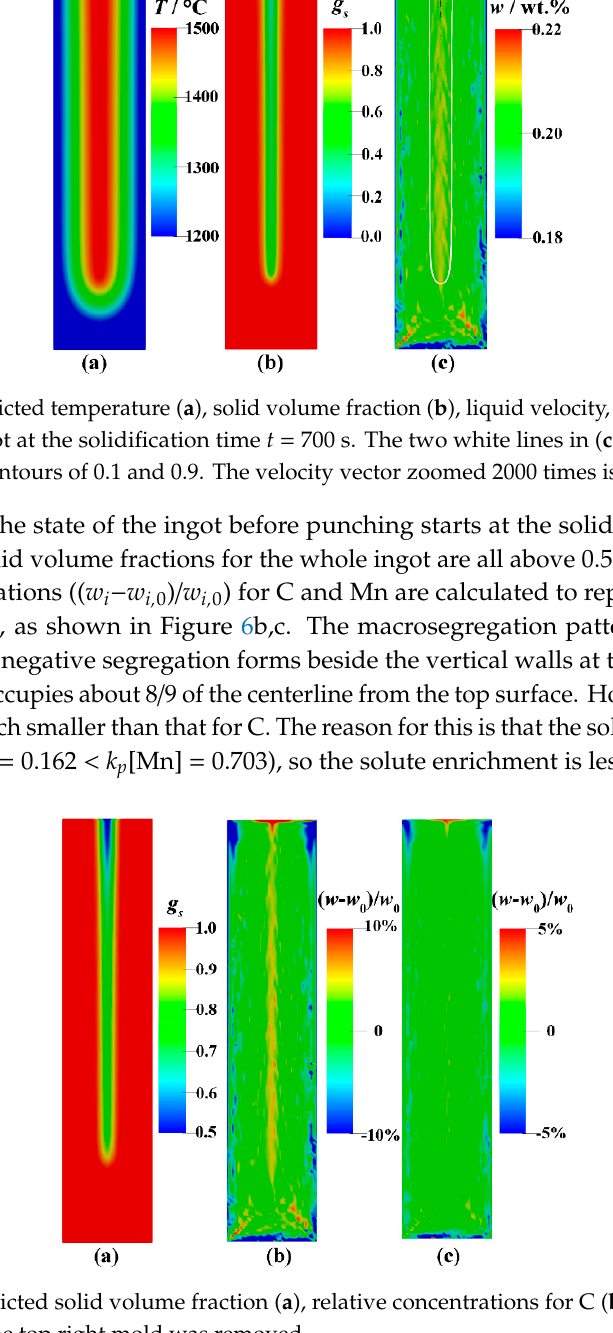
Figure 6. The predicted solid volume fraction ( a ), relative concentrations for C ( b ), and Mn ( c ) in the steel ingot when the top right mold was removed.